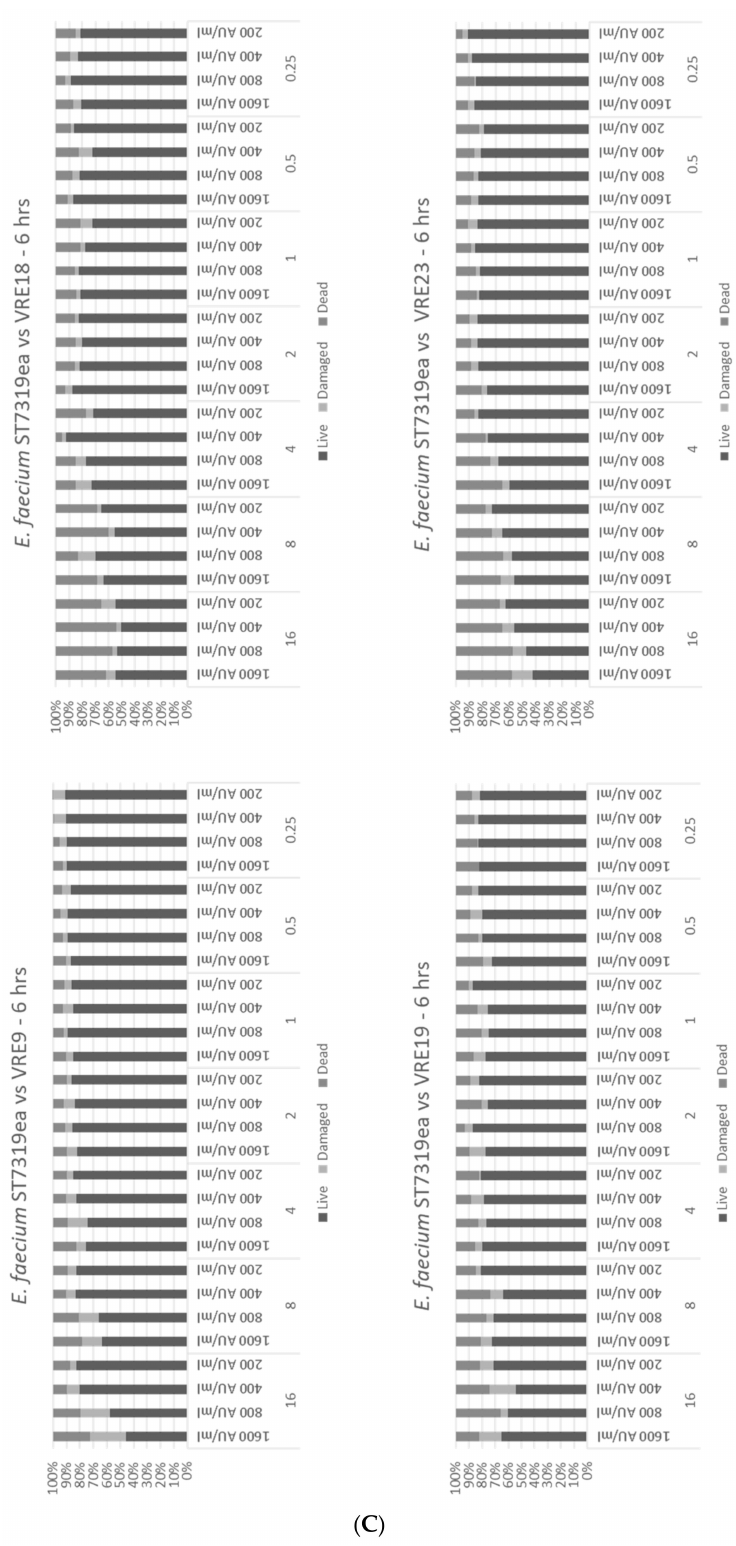
Figure 3. Viability test of VRE strains by flow cytometry. VRE strains ( E. faecium VRE9, E. faecium VRE18, E. faecium VRE19, and E. faecium VRE23, as indicated)—were challenged with different concentrations of vancomycin between 0.5 and 16 µ g mL − 1 and bacteriocins produced by ( A ): P. acidilactici ST3522BG, ( B ): P. pentosaceus ST3633BG, and ( C ): E. faecium ST7319ea with concentrations between 1600 and 200 AU mL − 1 , as indicated. After 6 h incubation at 37 ◦ C, cultures were analyzed by flow